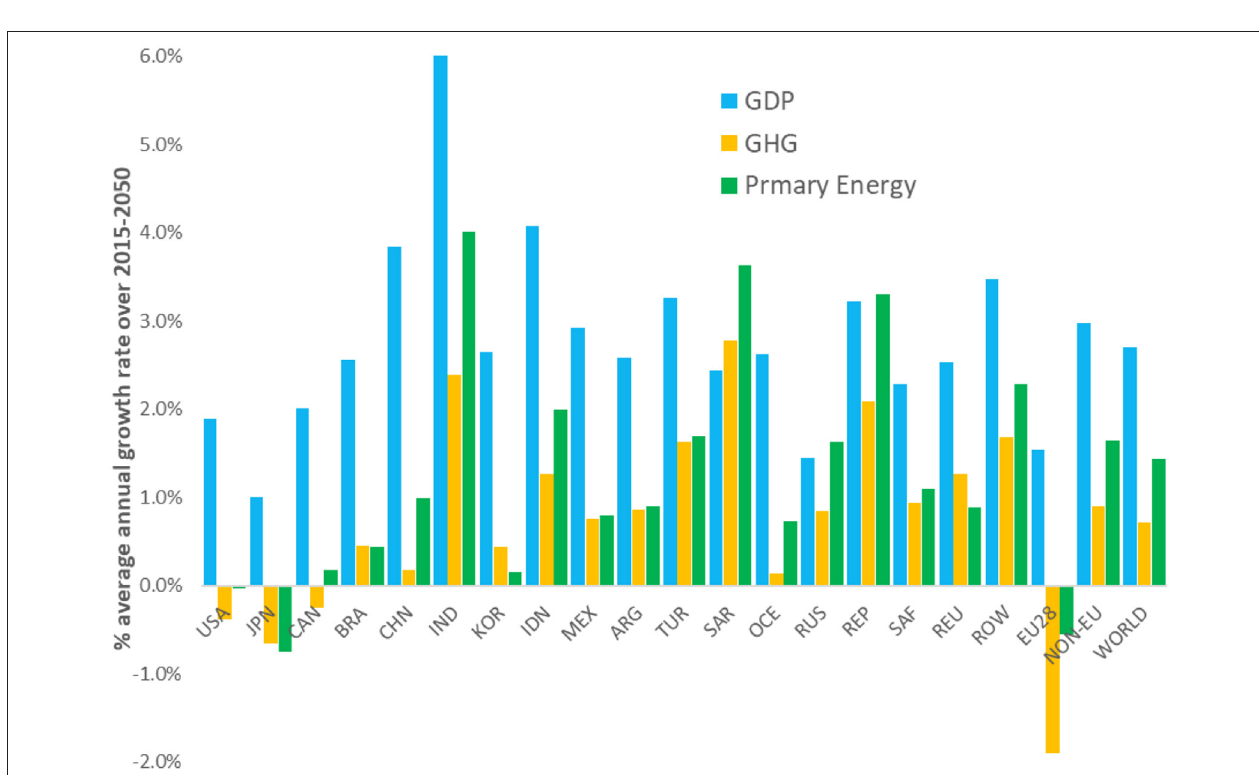
FIGURE 4 | Evolution of GDP, emissions, and primary energy in the Reference